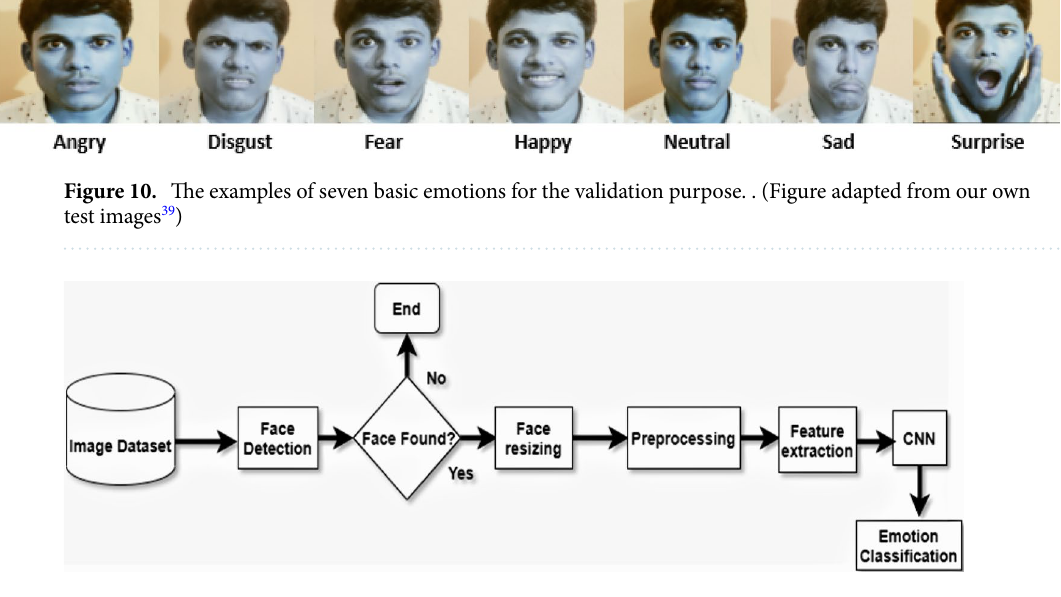
Figure 11. System flowchart of the proposed method (fusion feature extraction and fusion approaches with the proposed ConvNet Model) for emotion